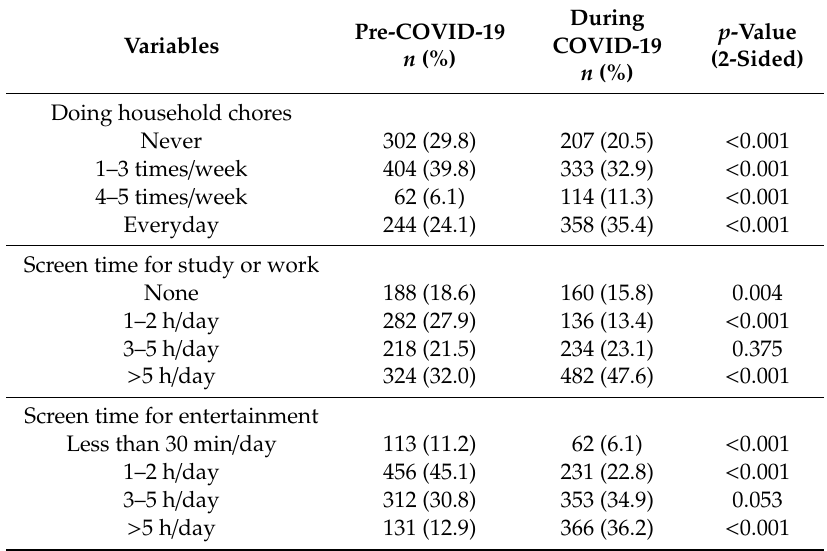
Table 7. Daily activities pre- and during COVID-19 pandemic ( n = 1012).